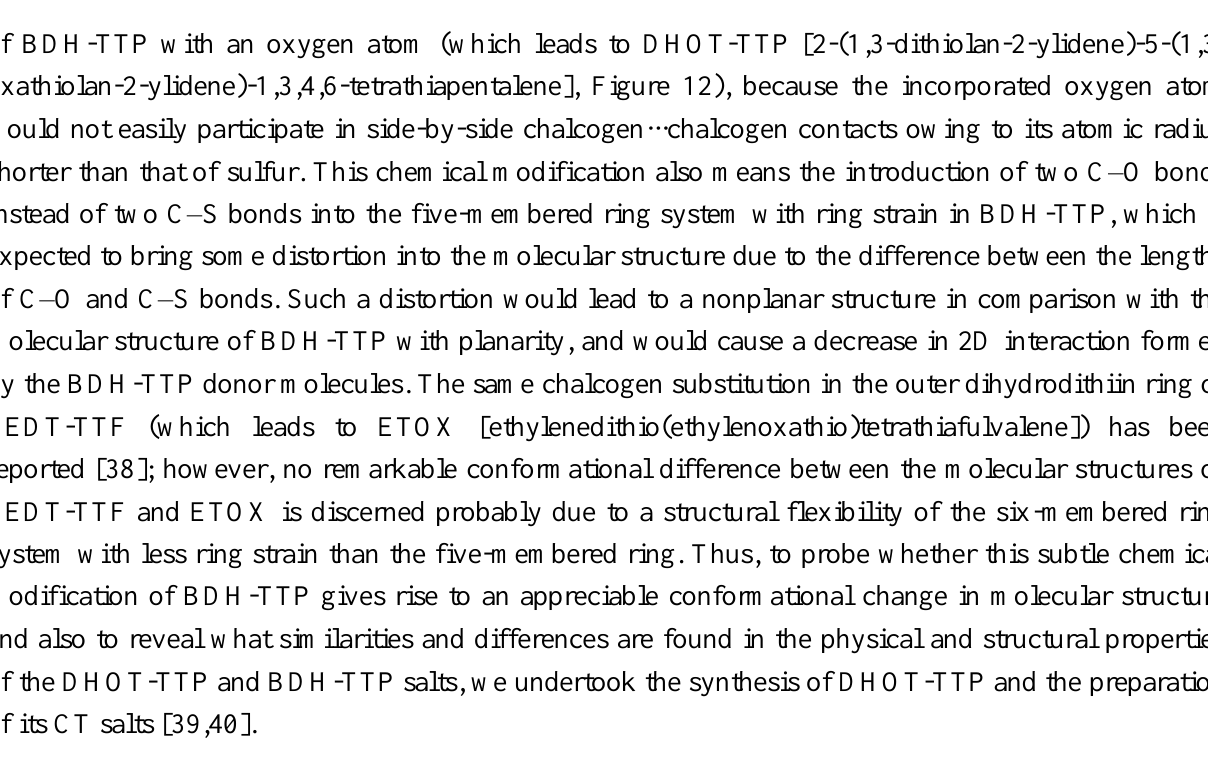
Figure 12. Monooxgen-containing analogues of sulfur-based π-electron